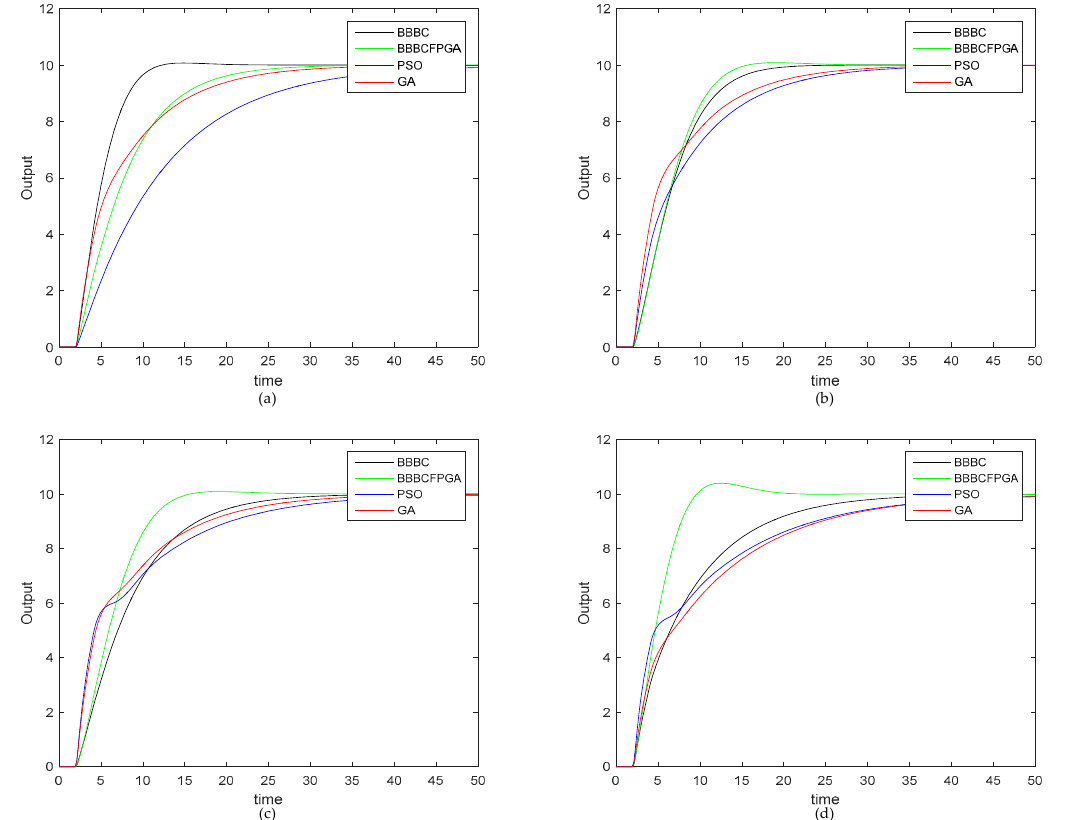
Figure 10. Time responses of four optimization methods (BBBC, BBBC-FPGA, PSO, GA) for different number of iterations ( a , b , c , and d for 100, 200, 500, and 1000 iterations, respectively). The BB–BC, PSO, and GA models run in a Core i7-3612QM@ 2.10 GHz (64-bit) processor. The